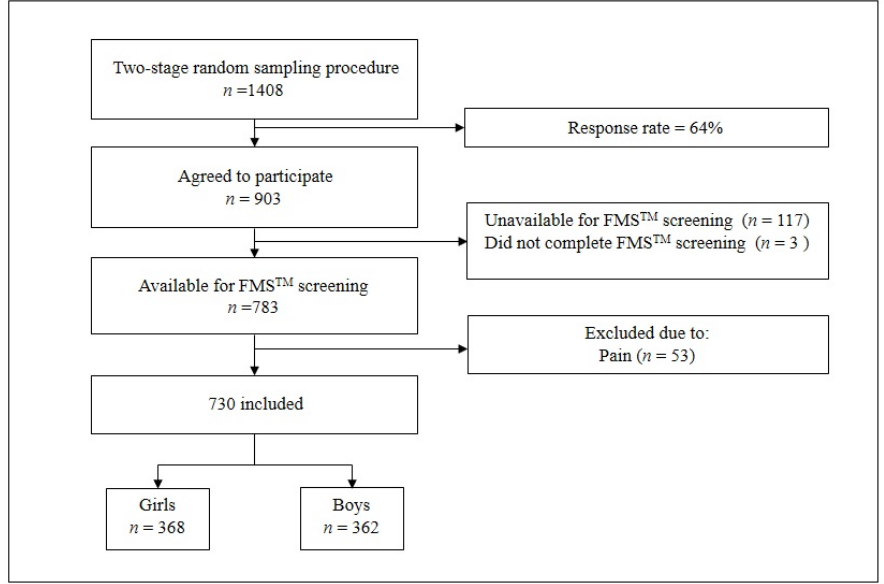
Figure 1. Flowchart of included participants.